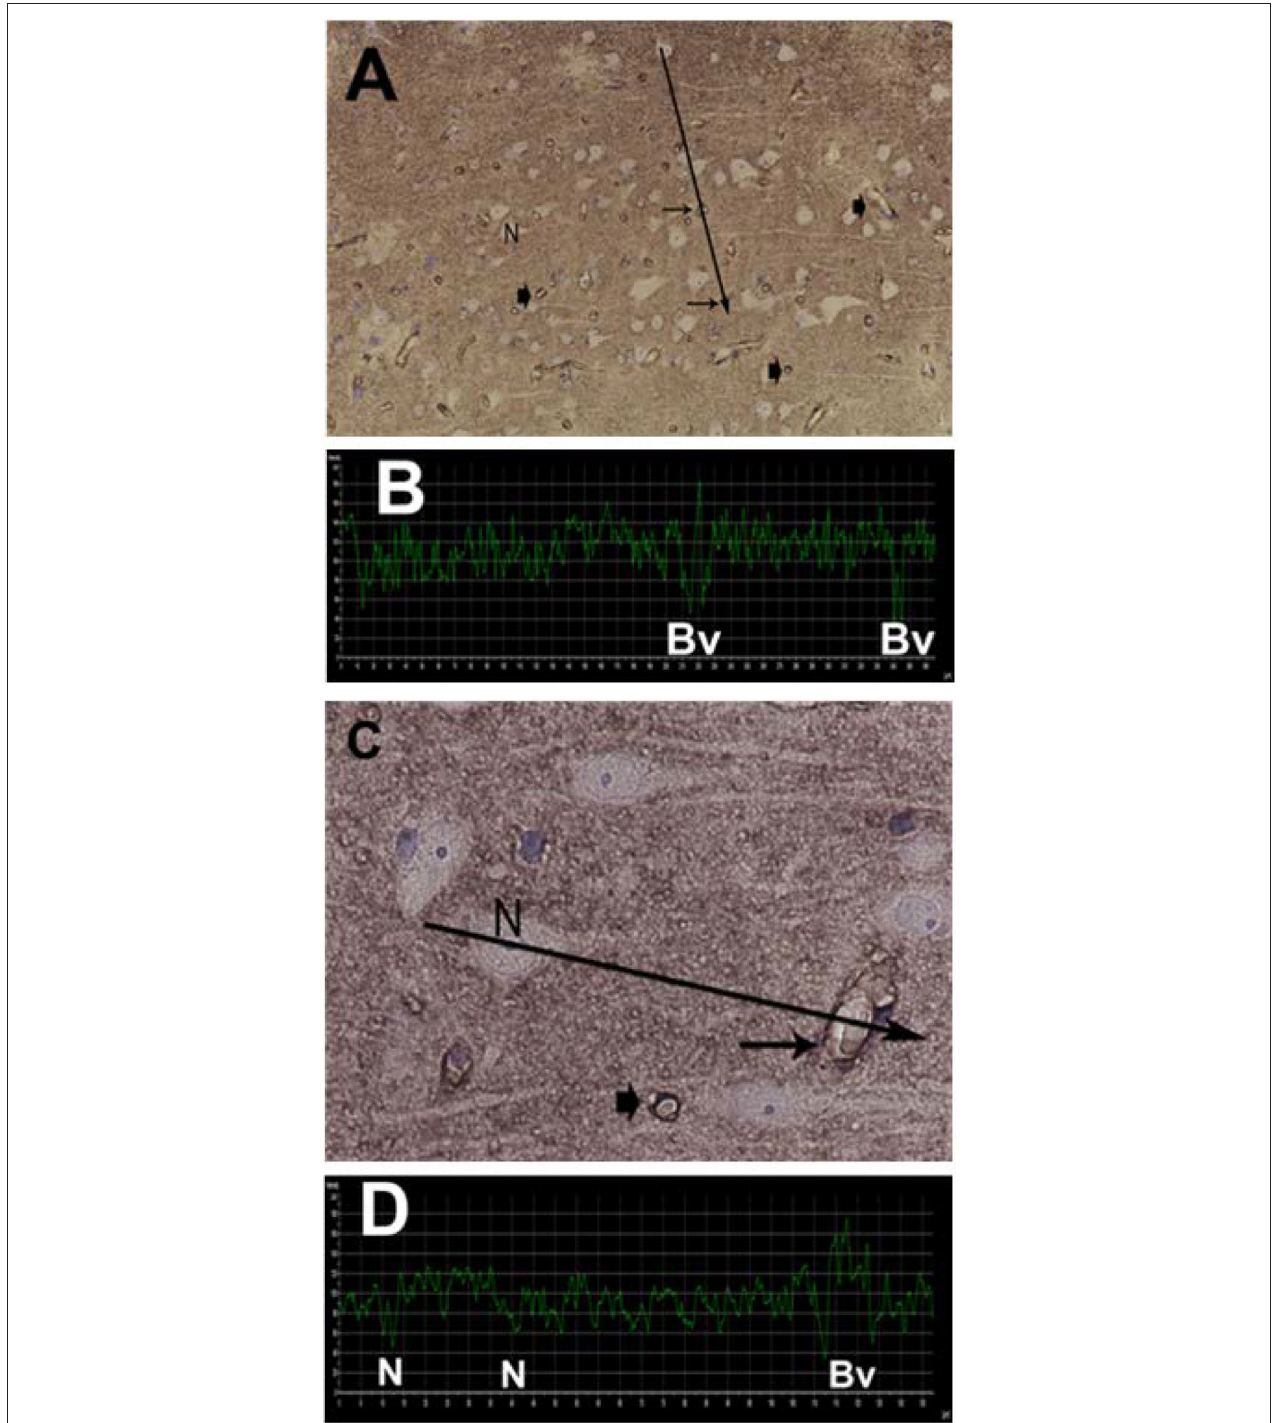
FIGURE 8 | Semi quantitative densitometry determination of AQP4 IR in cerebral biopsies in IIH patients. (A) The pattern of AQP4 IR is revealed. The densitometric measurement in (A) along a line is shown in (B) . Low transmission of light discloses strong AQP4 IR. The nerve cells are non-immunoreactive contrasting to the prominent AQP4-IR in the neuropil. Densitometric analysis enables mapping of the sites with reactive and non-reactive cell structures. (C) The relative intensity of the AQP4 IR can be mapped at the cellular level enabling more detailed analysis. The neurons are non-reactive. The perivascular astrocytic end-feet show prominent AQP4 IR. (D) The densitometric